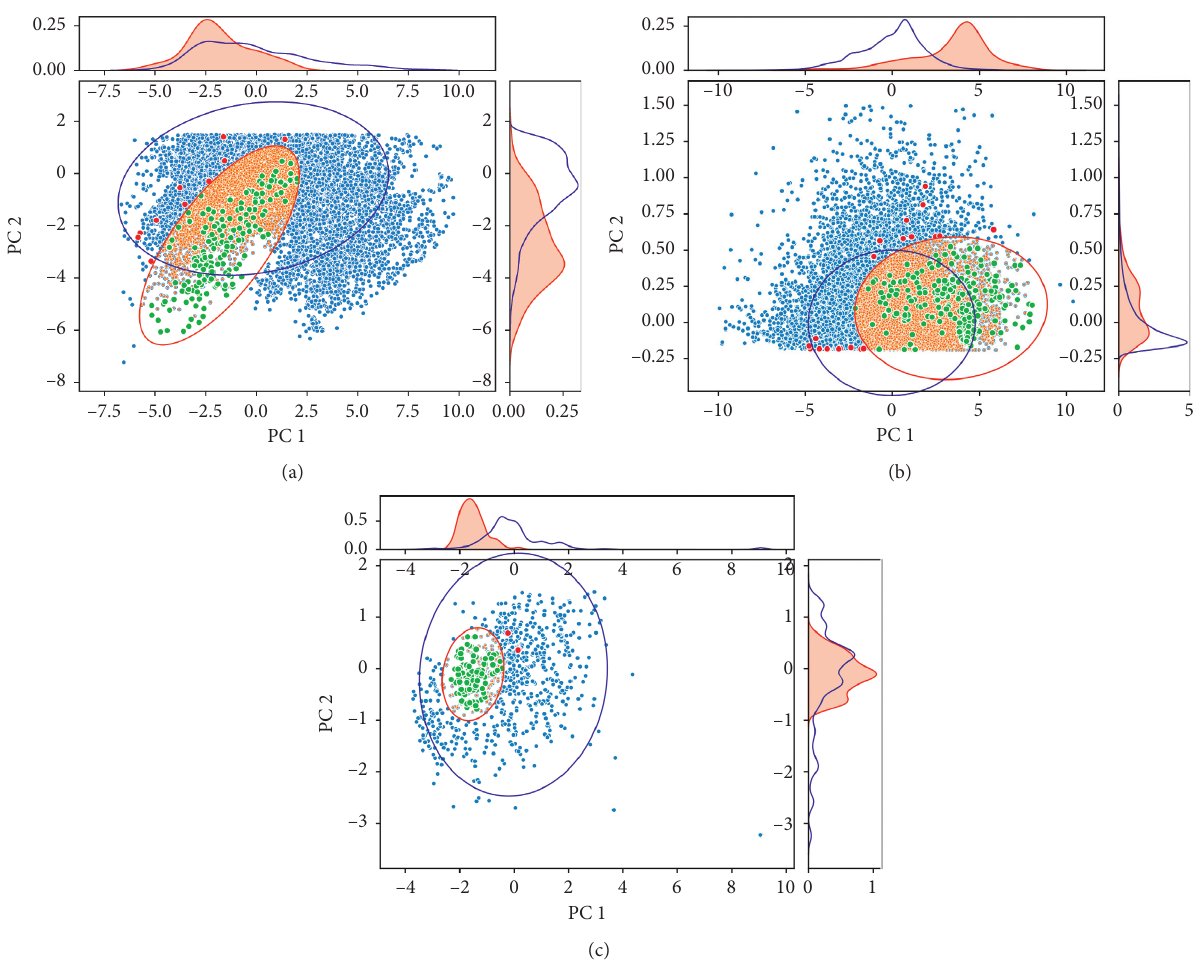
Figure 5: Using the samples of GCQ as an example, the results of 2-dimensional confidence ellipse analysis of climate, altitude, and chemical compositions of tobacco leaves were generated. (a), (b), (c) The results of 2-dimensional confidence ellipse analysis by using the data of climate, altitude, and chemical compositions of tobacco leaves. In the three plots, the red ellipse is constructed by using the samples of GCQ, and the blue one is constructed by using all samples of other locations. Each green data in the red ellipse denotes a sample of GCQ, and the red point in the area denotes the samples of other areas. Correspondingly, the samples of GCQ excluding in this ellipse are shown in red color, and samples of other areas are shown in blue